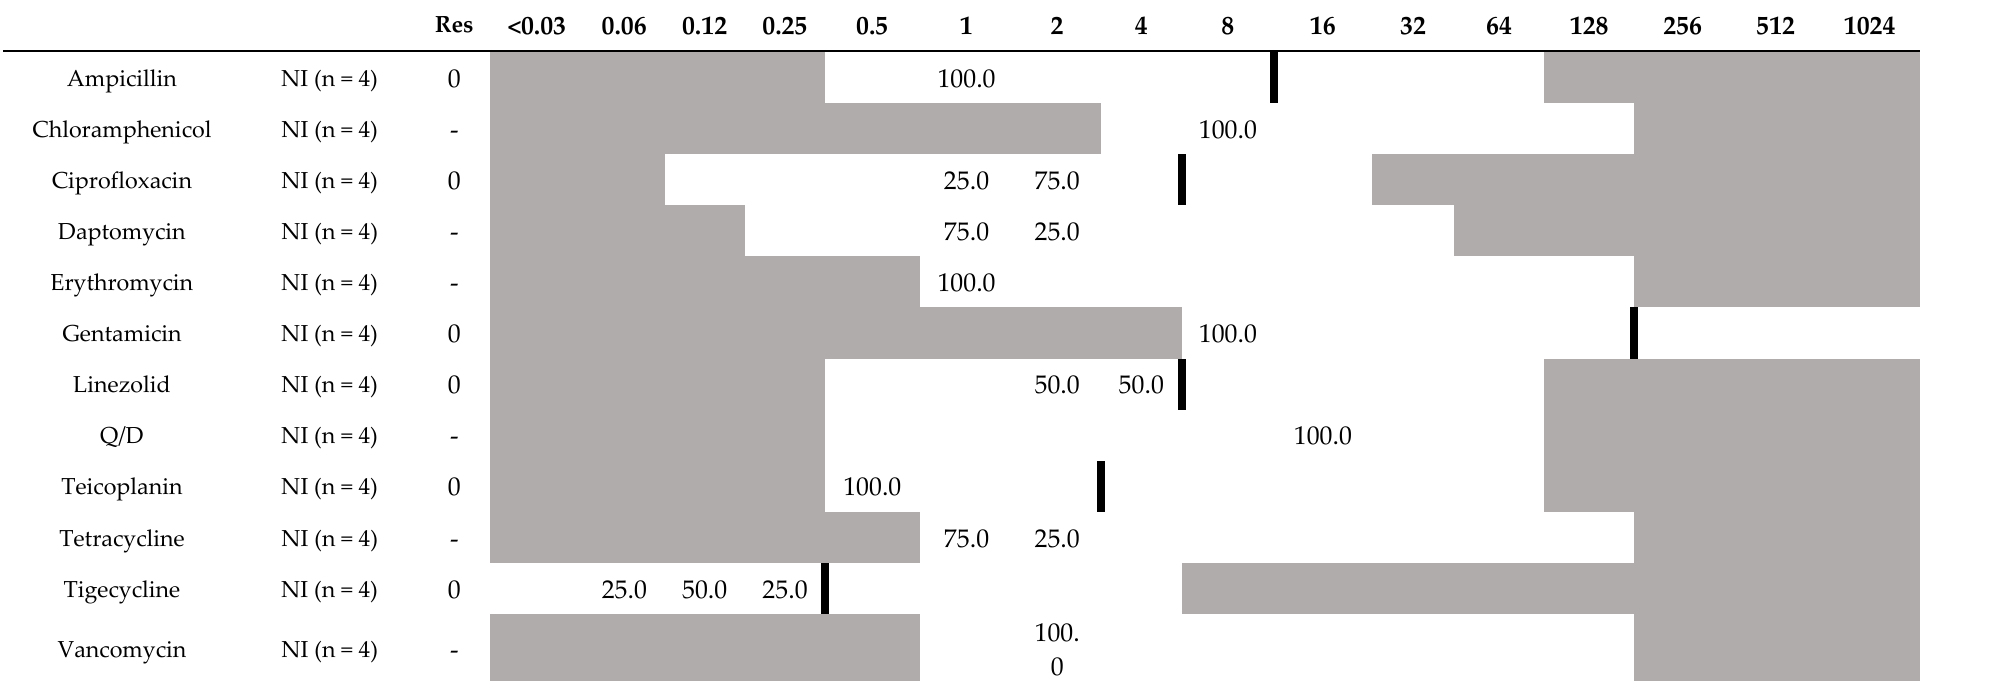
Table 5. Distribution of MICs (mg/L) and resistance of the four isolates of Enterococcus faecalis from the cranial vagina of non-inseminated mares (NI). The results are shown as the percentage of isolates at different MIC values.